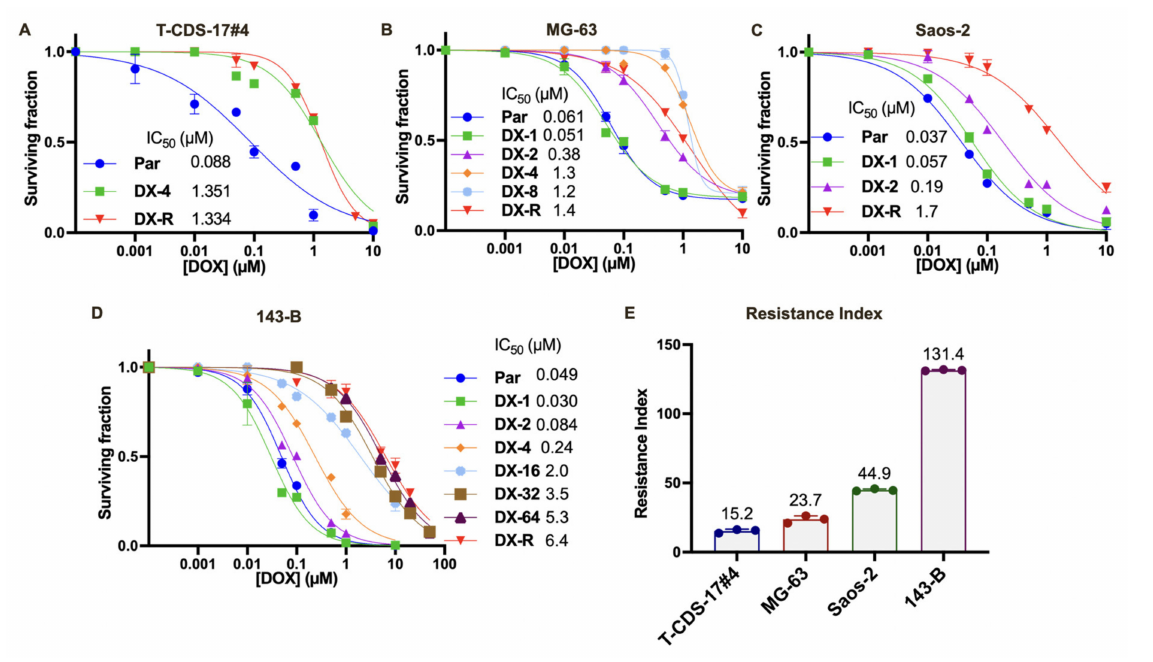
Figure 1. Establishment of DOX-resistant (DX-R) bone sarcoma cell lines. ( A – D ) Cell viability (WST-1 assay) measured after different rounds of DOX treatment to verify acquired resistance over time. IC 50 values for each condition are shown. ( E ) Final Resistance Index (RI) achieved of each DX-R bone sarcoma cell line